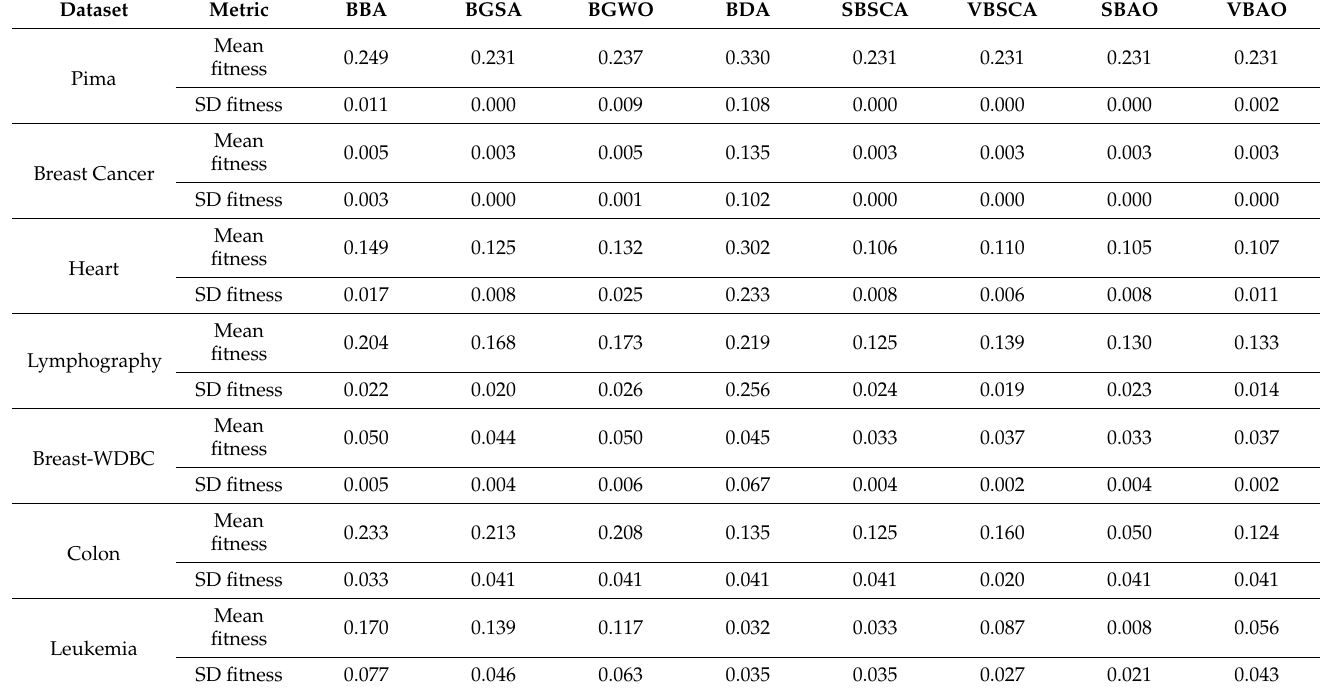
Table 9. The fitness comparison of SBAO and VBAO with other binary metaheuristic